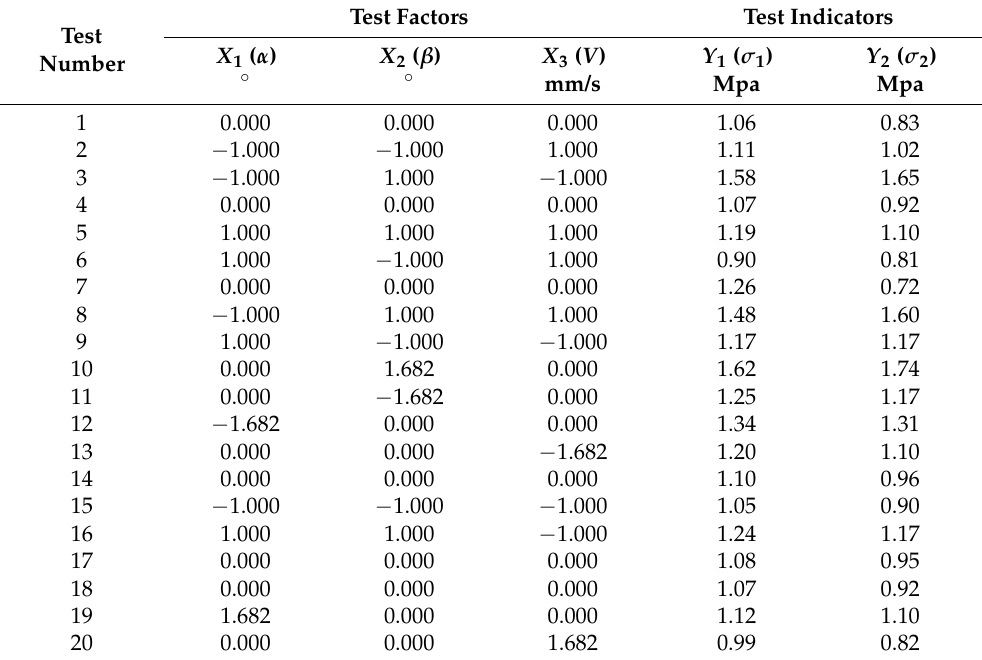
Table 5. Design and results of the orthogonal test in numerical